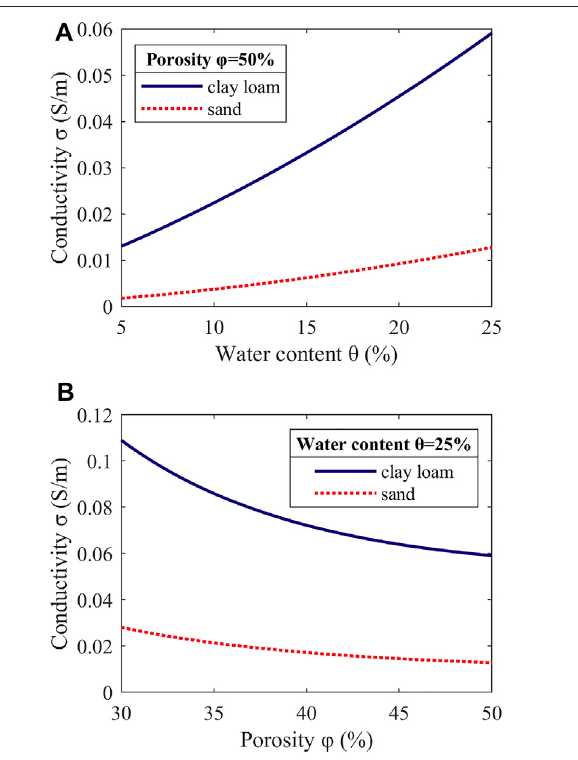
FIGURE 3 | (A) Relationship between water content and electrical conductivity in clay loam and sand. The porosity is set to φ = 50%. (B) Relationship between porosity and electrical conductivity in clay loam and sand. The water content is set to θ (cid:2)